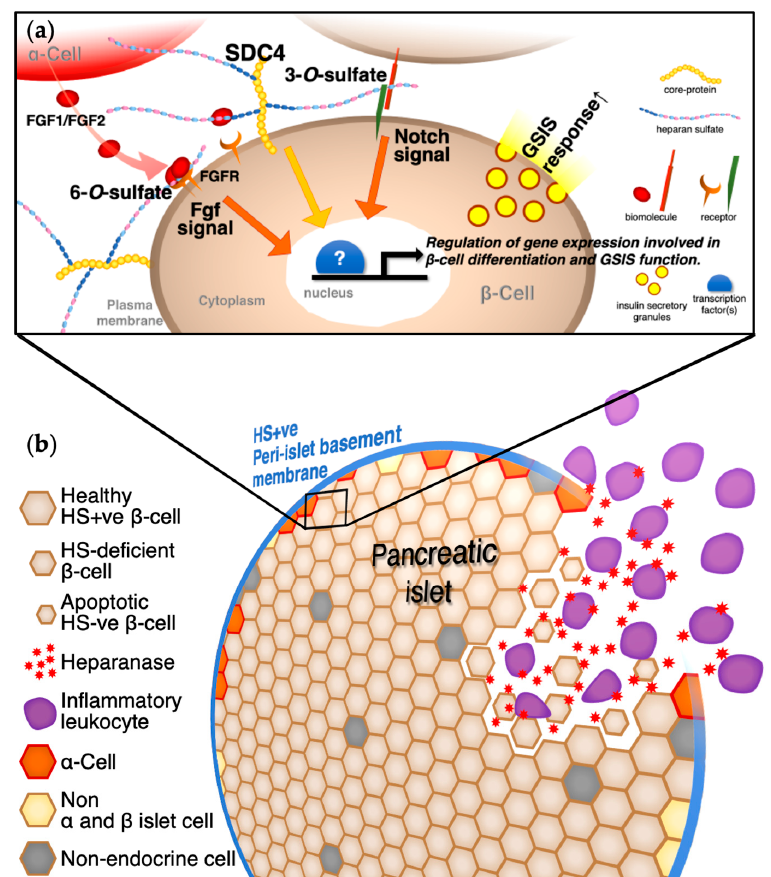
Figure 1. Schematic diagram of the actions of heparan sulfate proteoglycans (HSPGs) and related molecules on pancreatic islets and β -cells. ( a ) The actions of HSPGs in pancreatic β -cells should be considered on the heparan sulfate (HS) side bound to the core protein as well as via the intra- and extracellular domains of the transmembrane syndecan-4 (SDC4) core protein. These molecular mechanisms downstream of HSPGs appear to regulate gene expression involved in pancreatic β - cell differentiation and glucose-stimulated insulin secretion (GSIS) function and contribute to the maintenance and enhancement of GSIS-responsive function. ( b ) Multistep impairment by heparanase from inflammatory leukocytes against the HS of pancreatic islets and β -cells as one of several factors in the development of diabetes. Prolonged hyperglycemia also adds to the damage caused by heparanase from pancreatic β -cells, causing diabetes to increase in severity.